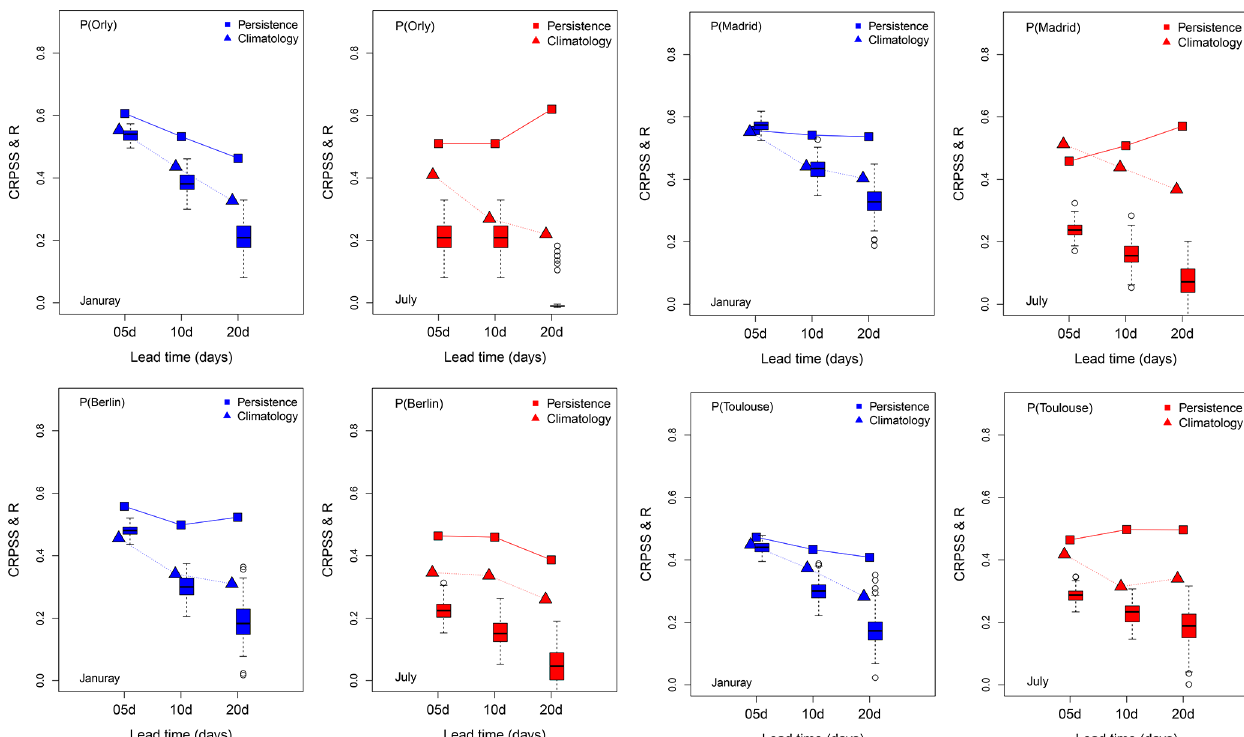
Figure 4. Skill scores for the precipitation of Orly, Madrid, Berlin, and Toulouse for lead times of 5, 10, 20d for January (blue) and July (red) for analogs computed from reanalyses of NCEP. Squares indicate CRPSS where the persistence is the baseline, triangles indicate CRPSS where the climatology is the reference, and boxplots indicate the probability distribution of correlation between observation and the median of 100 simulations for all days. The boxplot upper whisker is: min { 1 . 5 (q 75 − q 50 ) + q 50 , max ( CRPSS ) } . The boxplot lower whisker